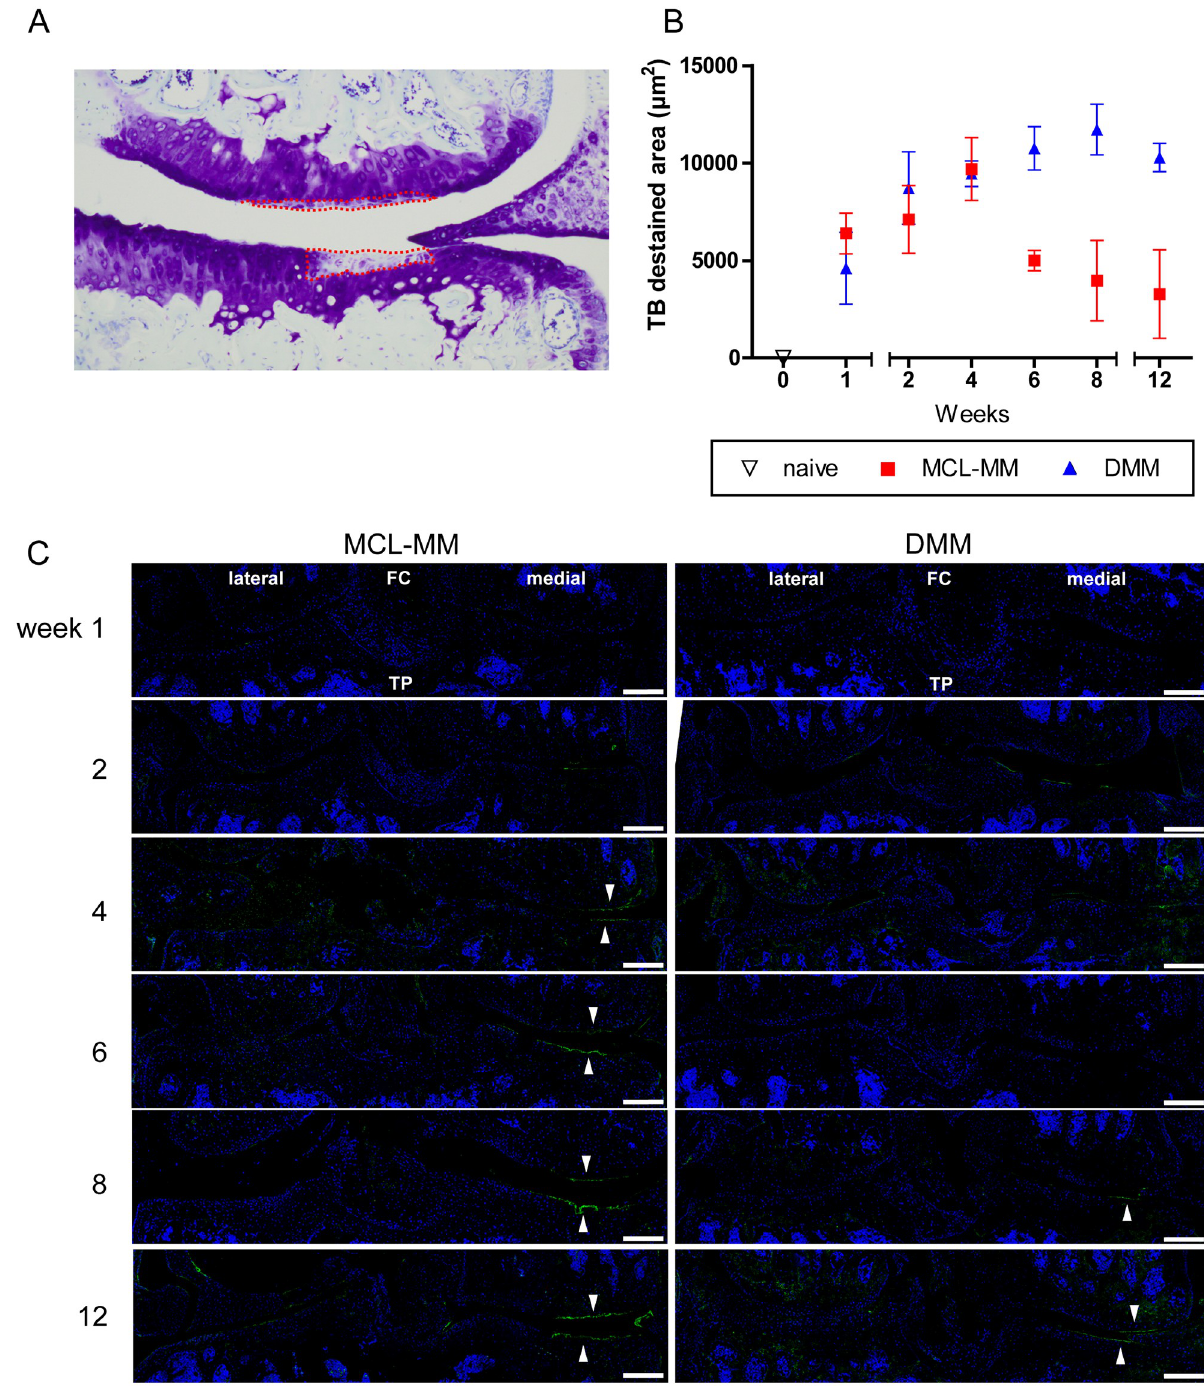
Fig 6. Alterations in cartilage proteoglycan- and collagen type II content in OA-progression. A) Quantification of toluidine blue destained areas on frontal sections showing the medial aspect of the knee joint. B) Dynamics of proteoglycan loss in the MCL-MM and DMM model. C) Immunofluorescent staining of collagen degradation products (green) and cell nuclei (blue) in MCL-MM, and DMM injured mice. Images show a frontal view on the lateral and medial aspect of the knee joint. Accumulation of collagen degradation products is detected at the cartilage surface in the weight bearing area (white arrow heads) in the medial aspect of the joint. Data represent mean values ± SEM. FC-femoral condyle, TP-tibial plateau, Bar = 250 μ m.